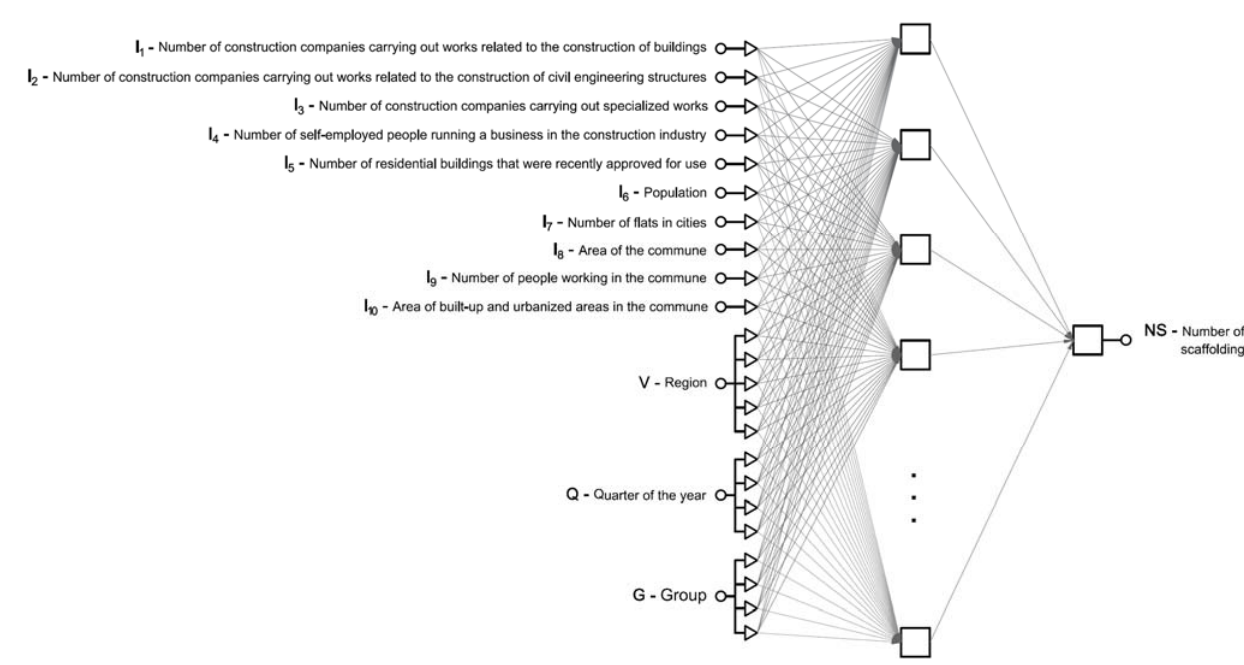
Figure 5. Construction of a single MLP network.